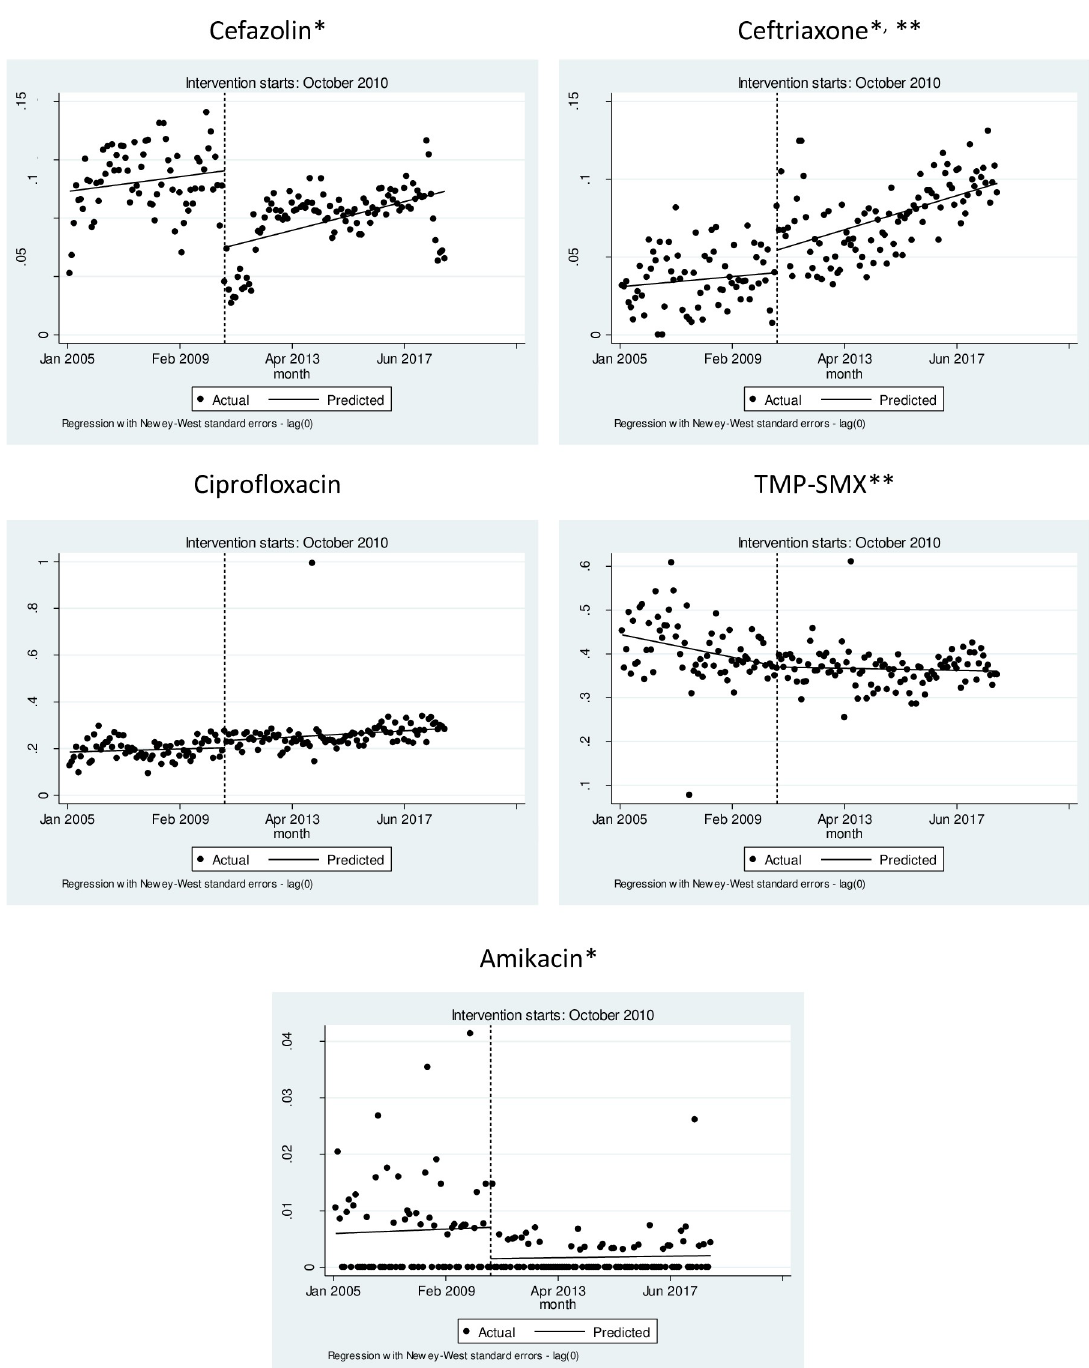
Fig 1. Interrupted time series (ITS) analysis (linear regression models) of time trends of antimicrobial resistance (expressed in Y axis in proportion) in Escherichia coli recovered from urine cultures of patients with community-onset urinary tract infection in inner S ã o Paulo State, Brazil, before and after the prohibition of over-the-counter sales of antimicrobials (antimicrobial sales without medical prescription). TMP-SMX, Sulfamethoxazole-trimethoprim. Notice that the number of months with zero resistance to Amikacin limits the accuracy of ITS. � Immediate impact of the intervention ( P < 0.05). �� Impact of intervention on time trends ( P <